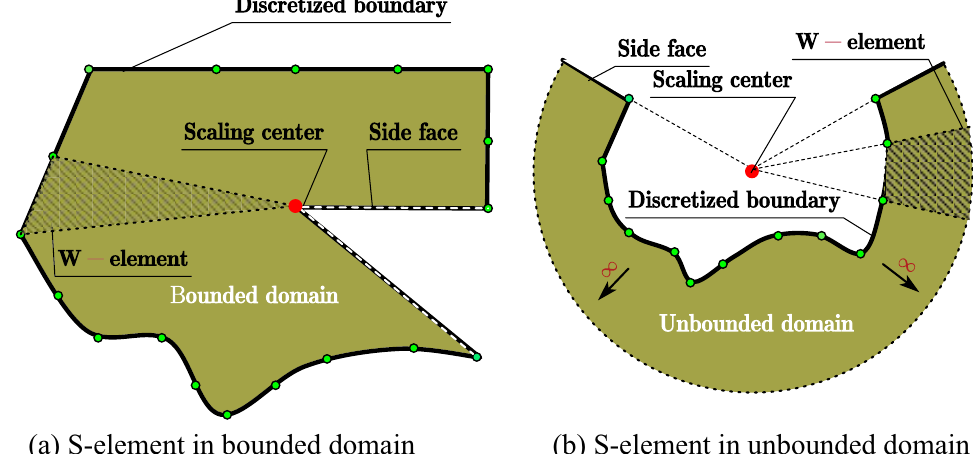
Figure 1. Spatial discretization of SBFEM for ( a ) S-element in bounded domain, ( b ) S-element in unbounded domain.